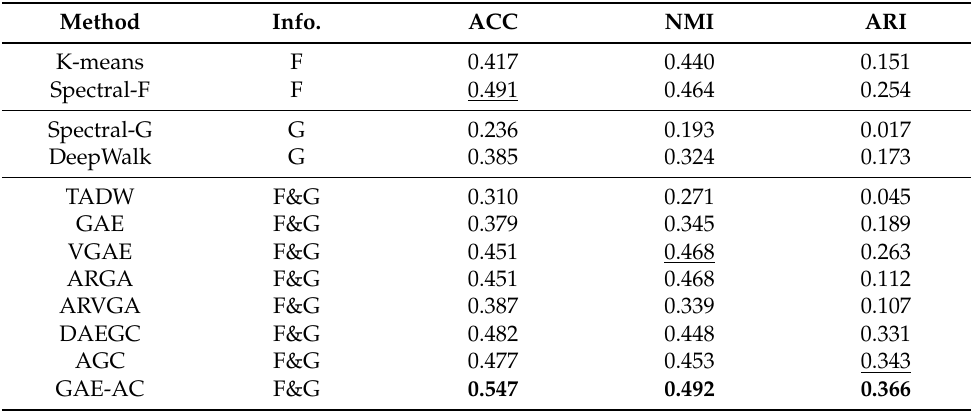
Table 4. Node Clustering Results on Wiki